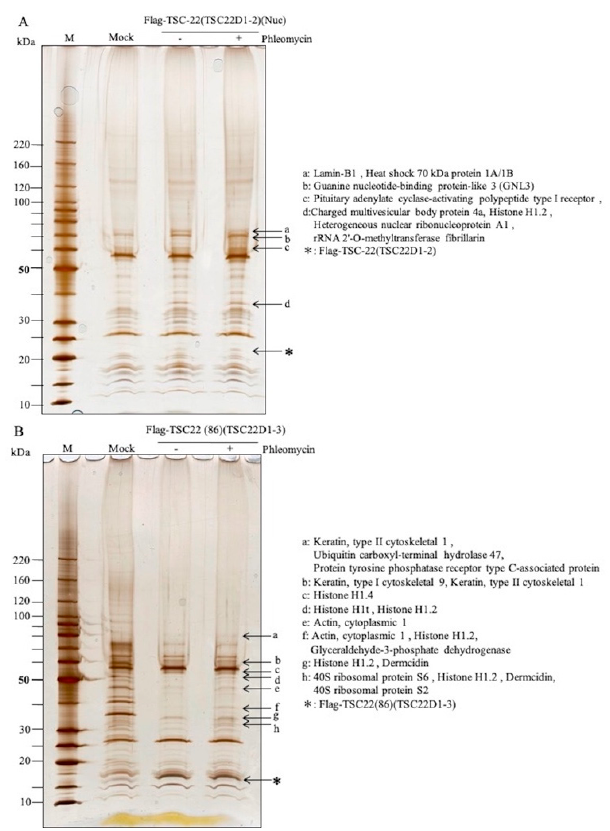
Figure 6. Identification of TSC-22-binding proteins in cells before and after DNA damage. ( A ): TSC- 22-binding protein (arrow) in the nuclear fraction after DNA damage by phleomycin in cells ex- pressing full-length TSC-22. a: Lamin-B1, Heat shock 70-kDa protein 1A/1B, b: Guanine nucleotide- binding protein-like 3 (GNL3), c: Pituitary adenylate cyclase-activating polypeptide type I receptor,